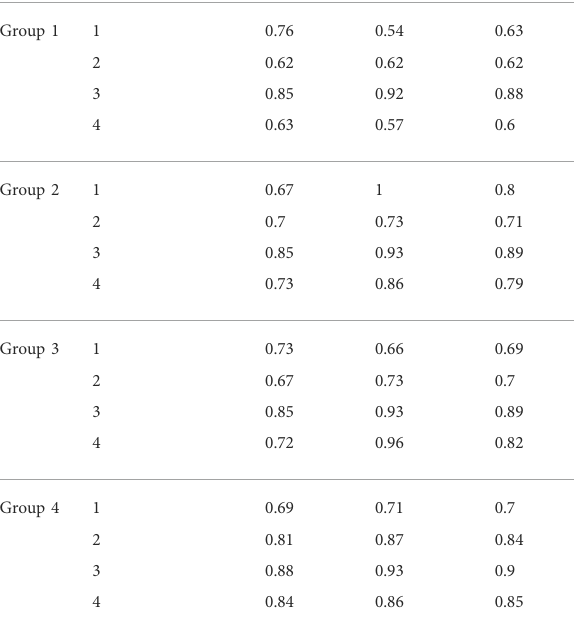
TABLE 5 Model accuracy in different targets on the WES data. Groups Average Targets Precision Sensitivity F1-score